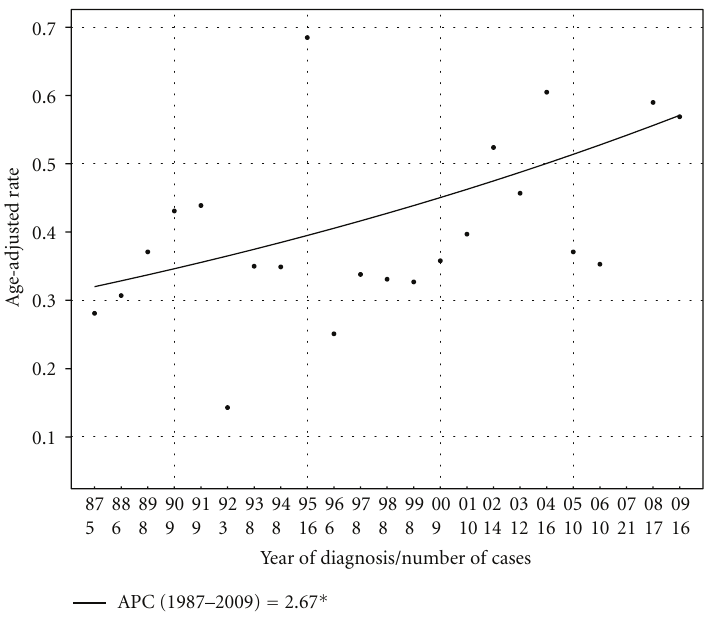
Figure 2: Age-adjusted incidence rates (in cases per million persons per year) with Joinpoint regression trendline for patients with melanoma of the nasal cavity in SEER 9 registries from 1987 to 2009. The APC over this time period was 2.7%.